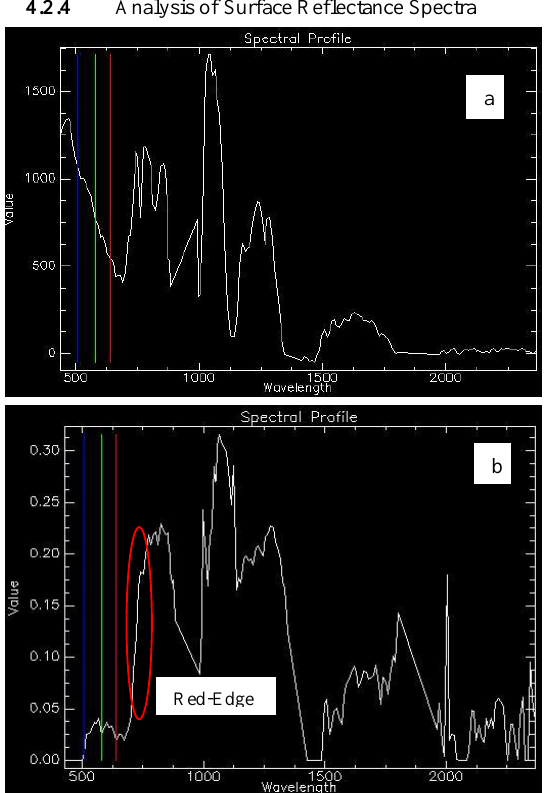
Figure 6: Radiance (a) and surface reflectance (b) spectra for healthy forest.